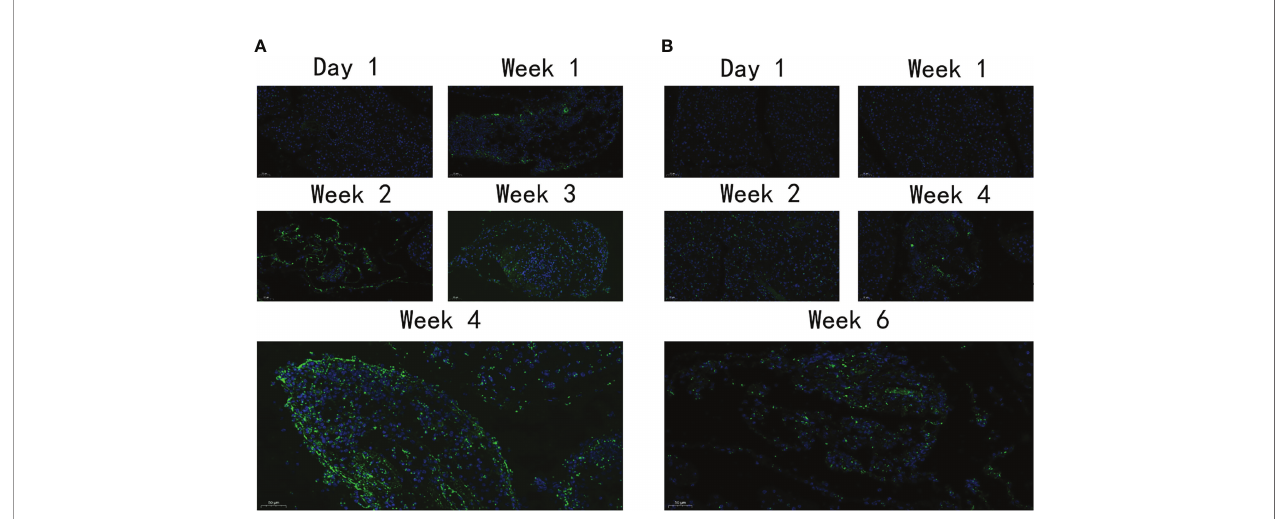
FIGURE 5 | The expression level of FN. (A) The expression of FN in PG at different time points. (B) The expression of FN in VG at different time points. FN, fi bronectin; PG, retrograde pancreatic duct injection group; VG, tail vein injection